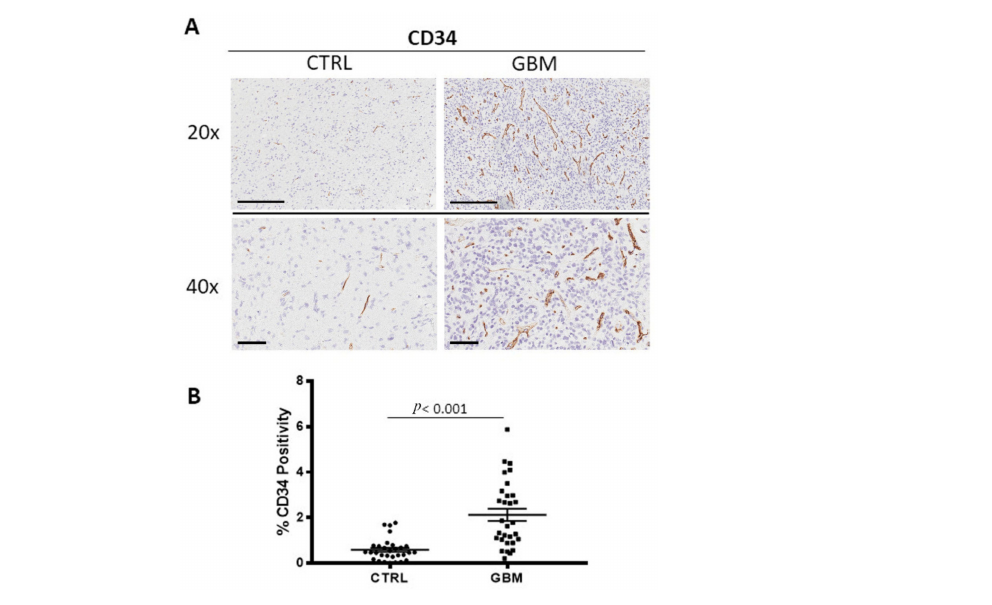
Figure 4. ( A ) Immunohistochemical staining for CD34 microvessels in both the center of tumor (GBM) and in the healthy surrounding areas (CTRL). Scale bar: 60 µ m (40 × ), 200 µ m (20 × ). ( B ) Morphometric analysis indicating the percentage of CD34 microvessel positivity in GBM and CTRL samples ( B ).